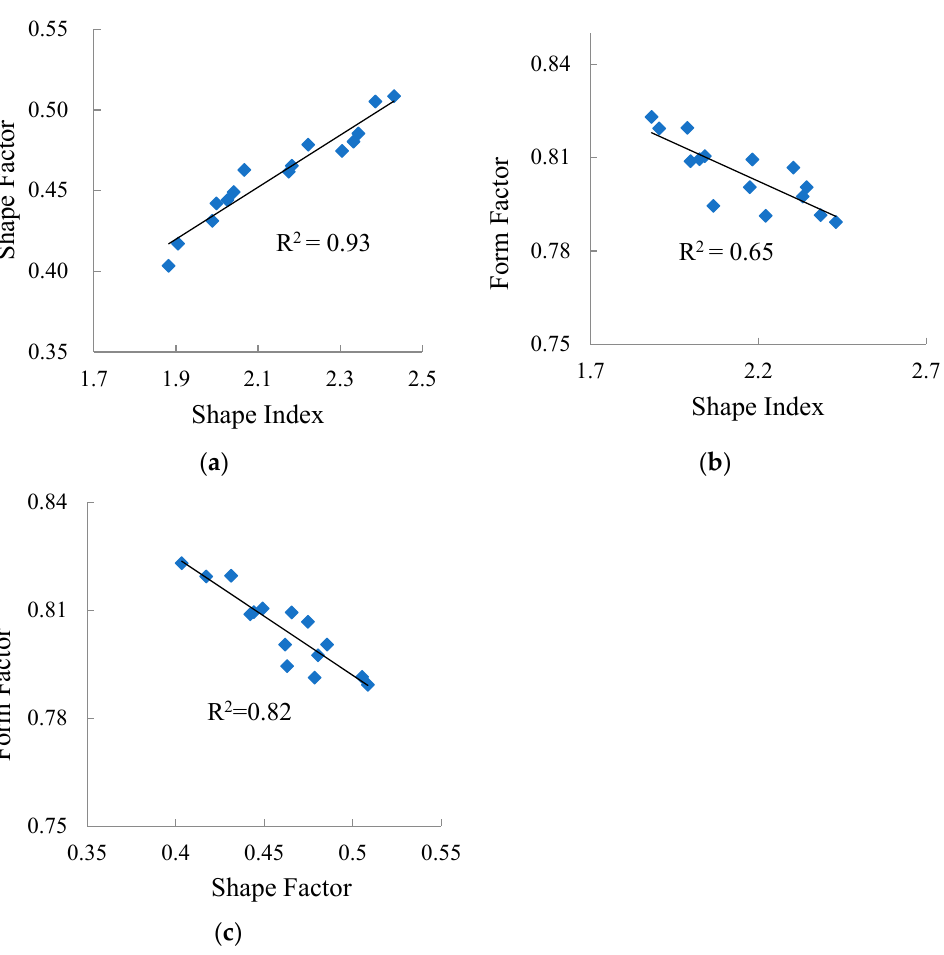
Figure 7. Test results of aggregate surface texture indicator.